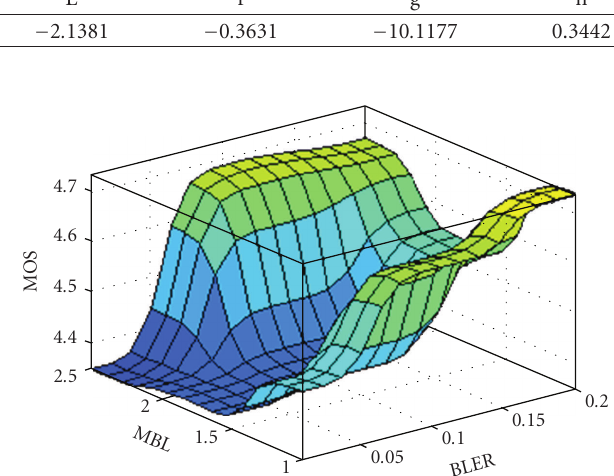
Figure 19: MOS versus BLER versus MBL for the three content